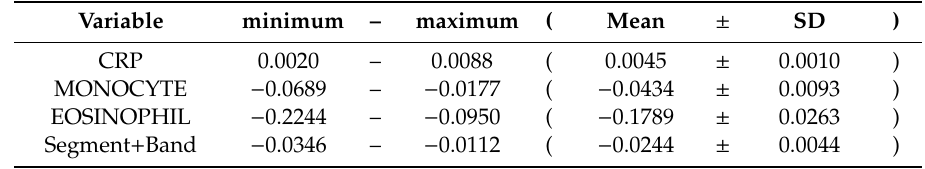
Table 4. The maximum value, minimum value, mean value, and standard deviation of multivariate binary logistic regression coe ffi cients of significant risk factors.